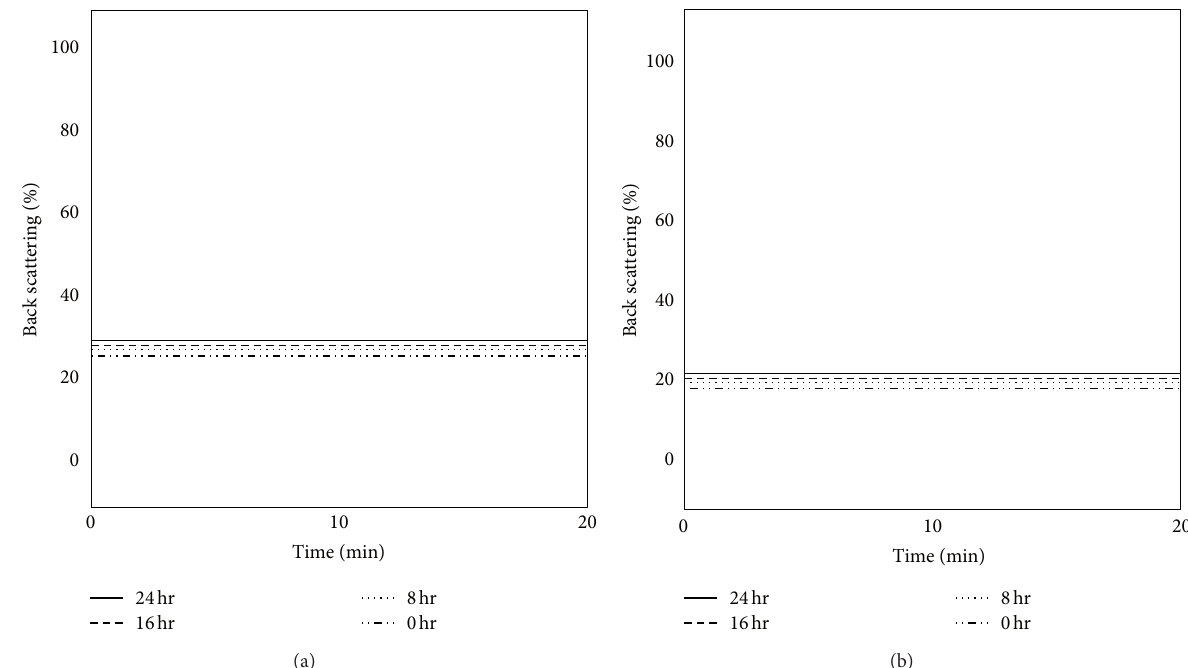
F 5: Study of stability of Ru nanoparticles at different stabilizing agents, (a) SDS and (b) PVP, using Turbiscan.